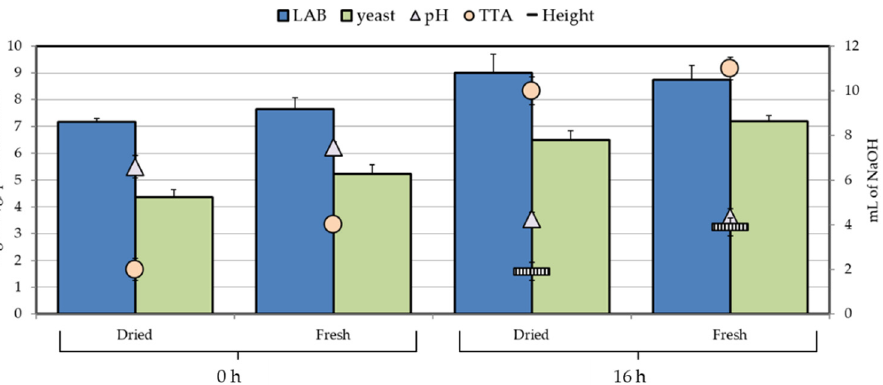
Figure 4. Microbial counts, pH, and TTA in sourdough produced with starter culture E75-B72 as fresh or freeze-dried cells at time 0 and after 16 h of fermentation at 28 °C. Height is reported as dashed bars. Analyses were performed in triplicate. Results are reported as mean values ± SD.